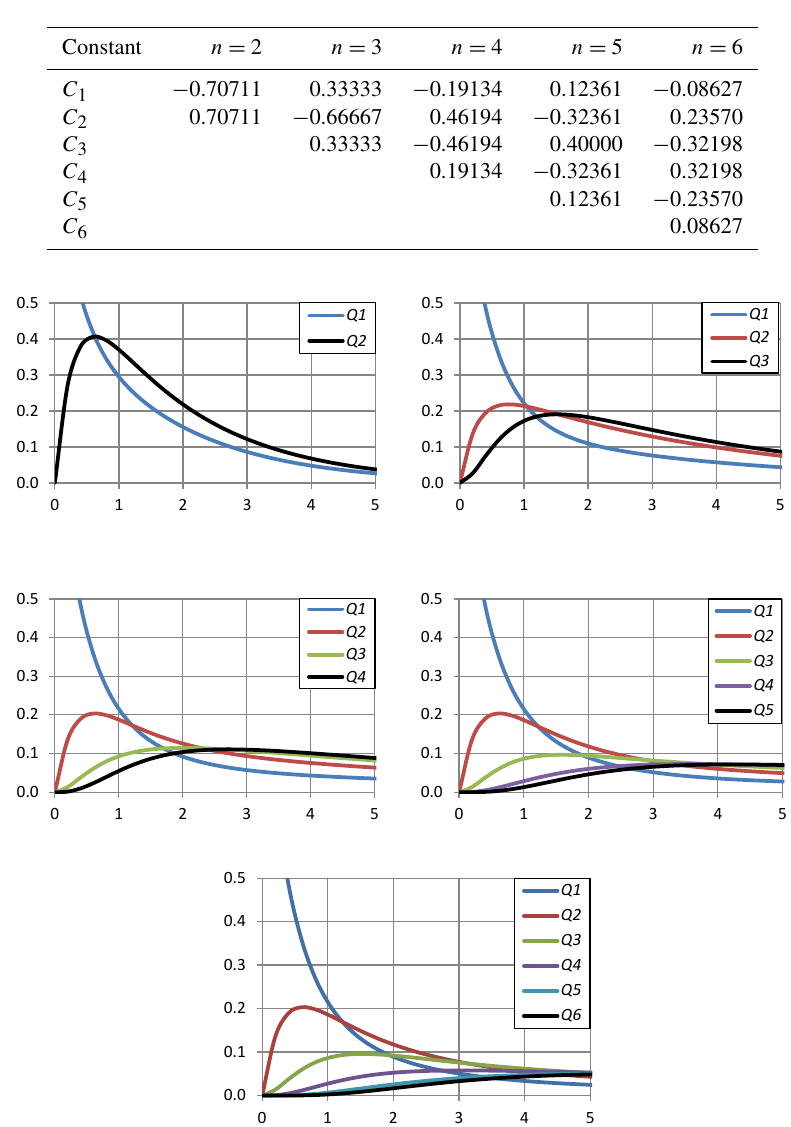
Table 1. Numerical values of constants of integration to the instantaneous unit hydrograph (IUH) in the SC2 model ( k = 1).